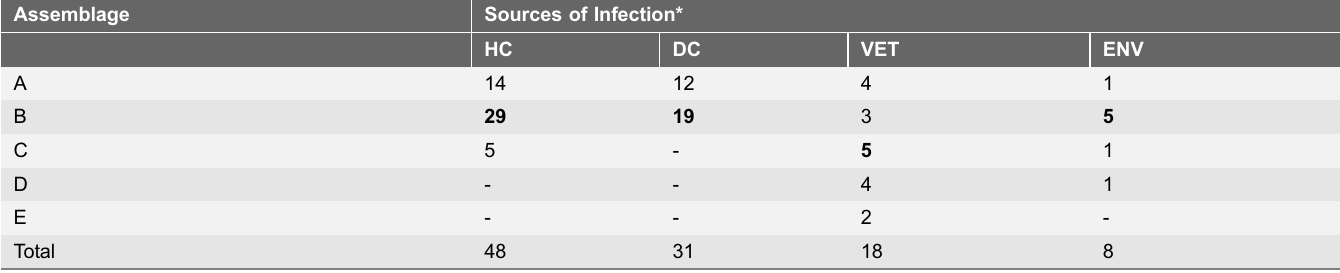
The haplotypes identified in each genetic assemblage are presented for each gene. Bold numbers indicate the assemblage that contributed most to the haplotypes. * Hospital group (HC), day-care center group (DC), veterinary group (VET) and environmental group (ENV).